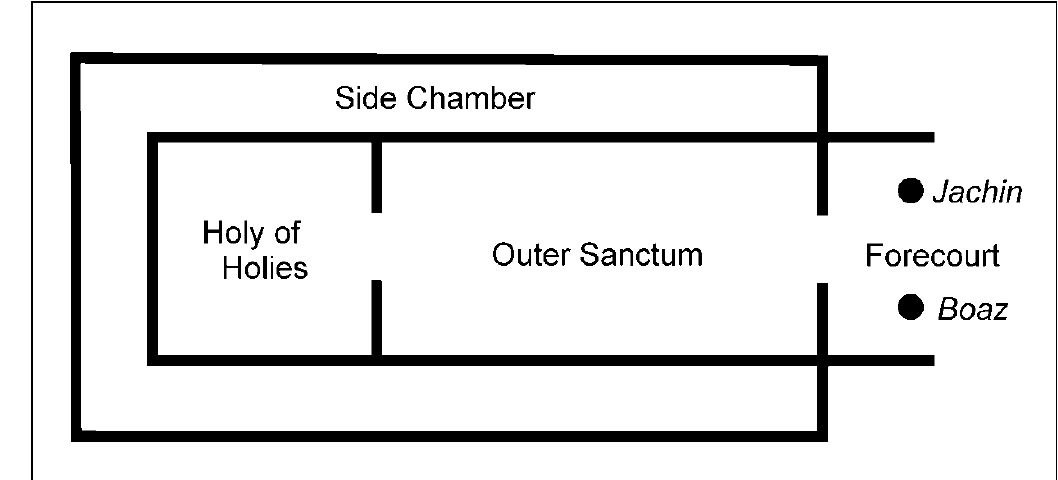
Figure 2. The different components of Solomon’s Temple: the pair of columns at the entrance, the Forecourt, the Outer Sanctum, the Holy of Holies, and the side chamber.